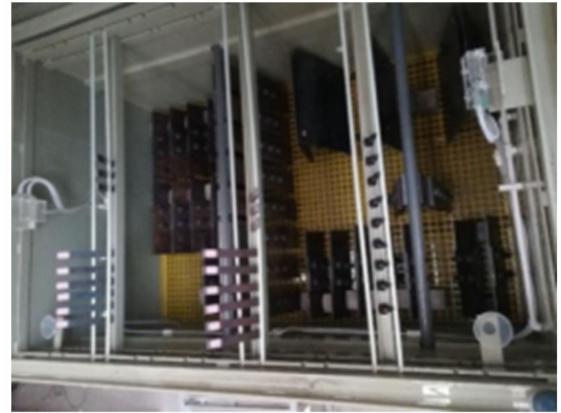
Figure 9. Accelerated corrosion